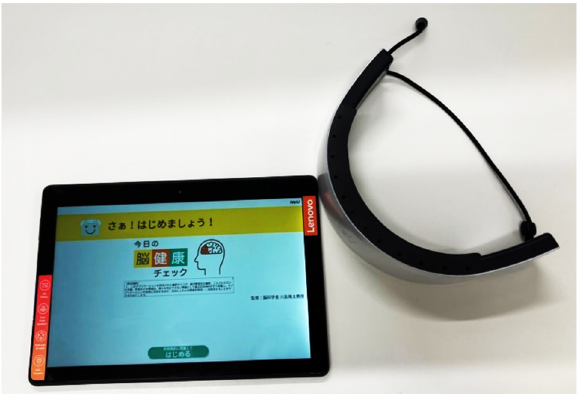
Figure 3. Measurement device. Figure 3 shows the HOT-2000 and the tablet that performed the TMT (for Japanese).